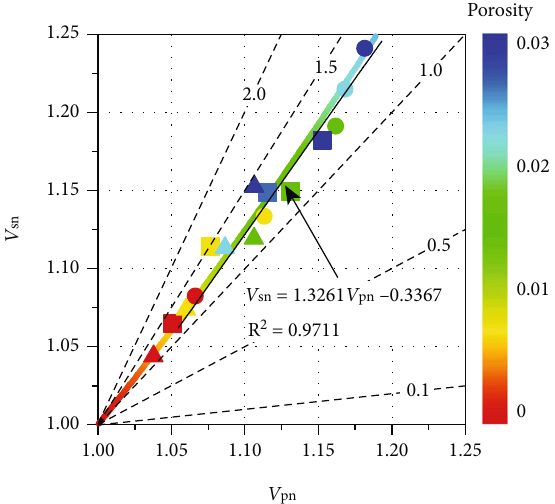
Figure 9: The normalized V The dashed lines indicate the slopes. The coloured line is the prediction based on the DEM modelling.